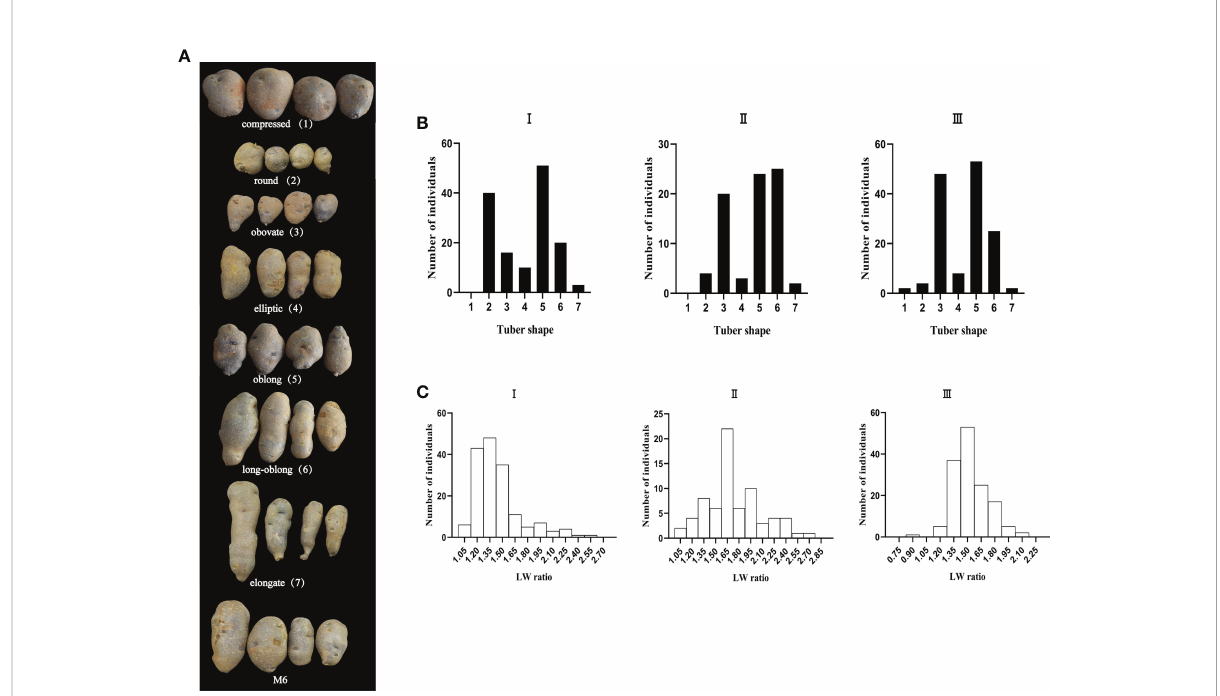
FIGURE 1 Phenotype of tuber shape in the PM7 population, and frequency distribution of tuber shape category and LW ratio in tree environment (environment I – III). (A) Photograph illustrating tuber shape variation in the PM7 population and the phenotype of the parent M6. Tuber shape was assessed on a 1-7 scale, where 1-7 were represented as compressed (1), round (2), obovate (3), elliptic (4), oblong (5), long-oblong (6), and elongate (7). (B) The frequency distribution of tuber shape category in the PM7 population in environment I – III. (C) The frequency distribution of LW ratio (the ratio of tuber length to width) in the PM7 population in environment I –